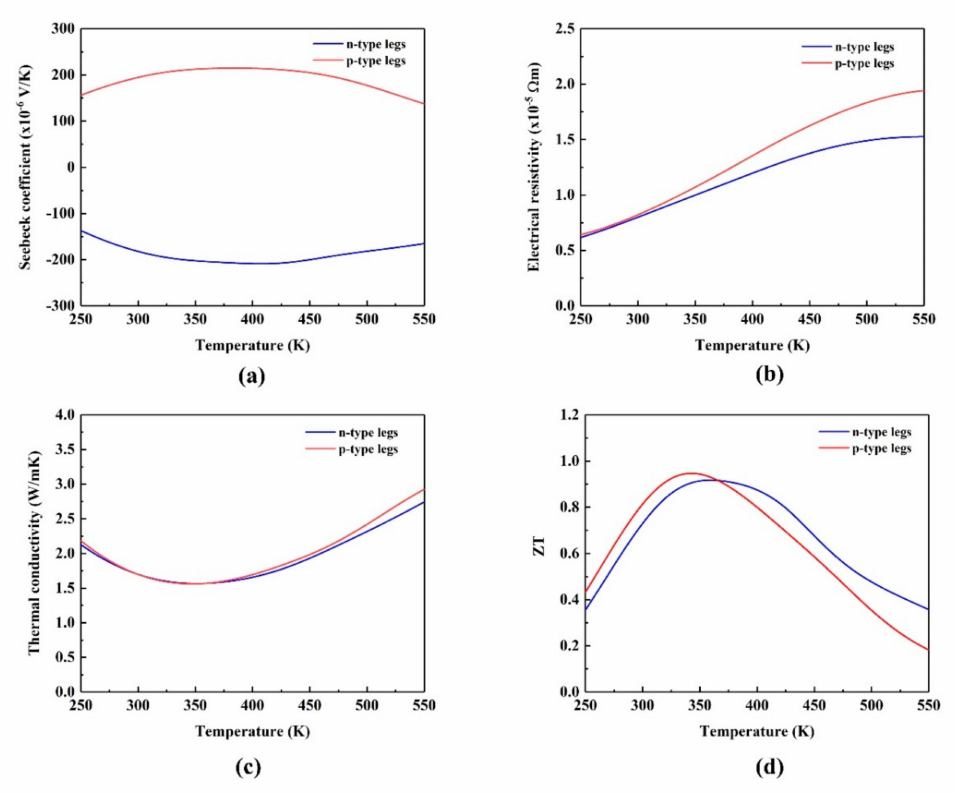
Figure 3. Temperature dependent thermoelectric material properties ( a ) Seebeck coe ffi cient ( b ) electrical resistivity ( c ) thermal conductivity and ( d ) figure of merit (ZT)